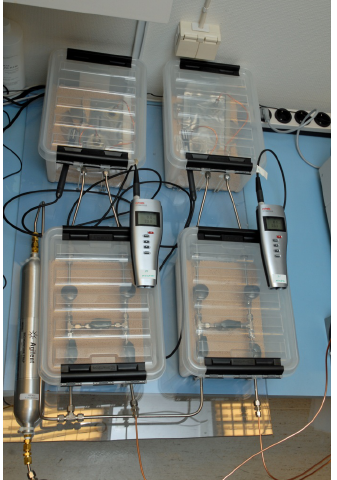
Figure 8. Battery packages and valve system inside plastic boxes acting as a climate chambers. Test set-up for the Mocon Aquatran